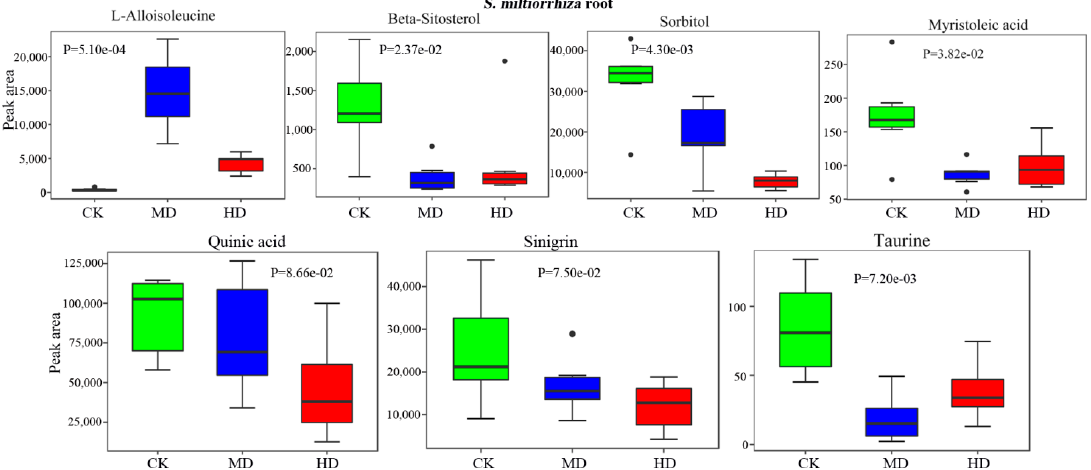
Figure 6. Metabolic profiles of several bioactive constituents in Salvia miltiorrhiza Bunge root. CK: control. MD: moderate drought. HD: high (severe) drought. Univariate statistic method Kruskal–Wallis H test was used to analyze the different levels of metabolites. Data were expressed as median and range (interquartile range).